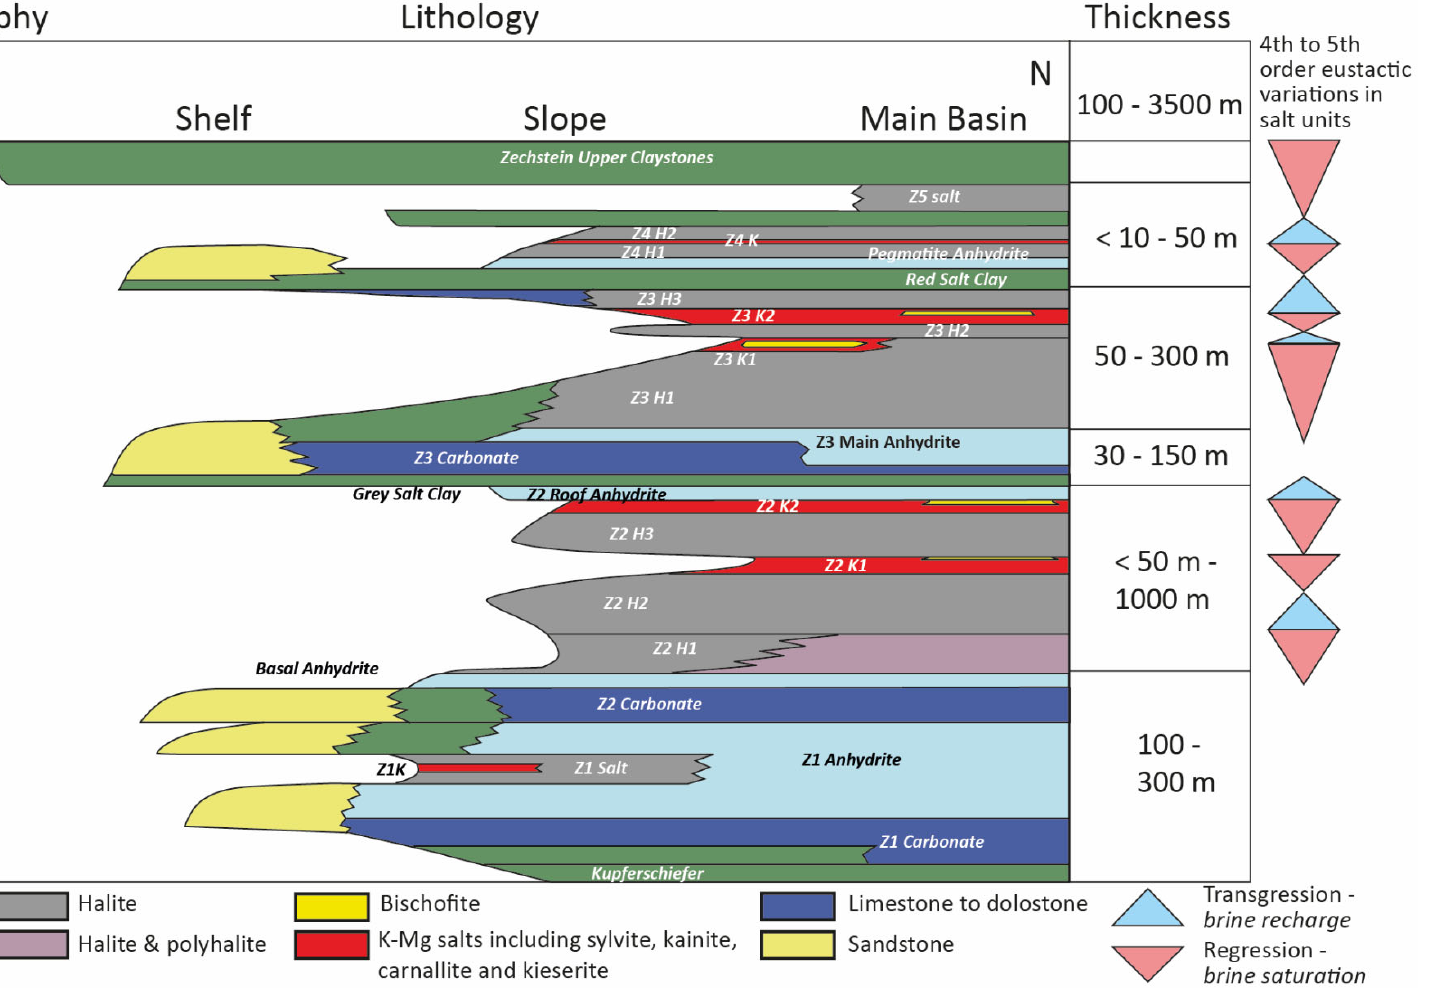
Figure 7. Updated general lithostratigraphic chart of the Zechstein in the Netherlands (modifier from [14]).